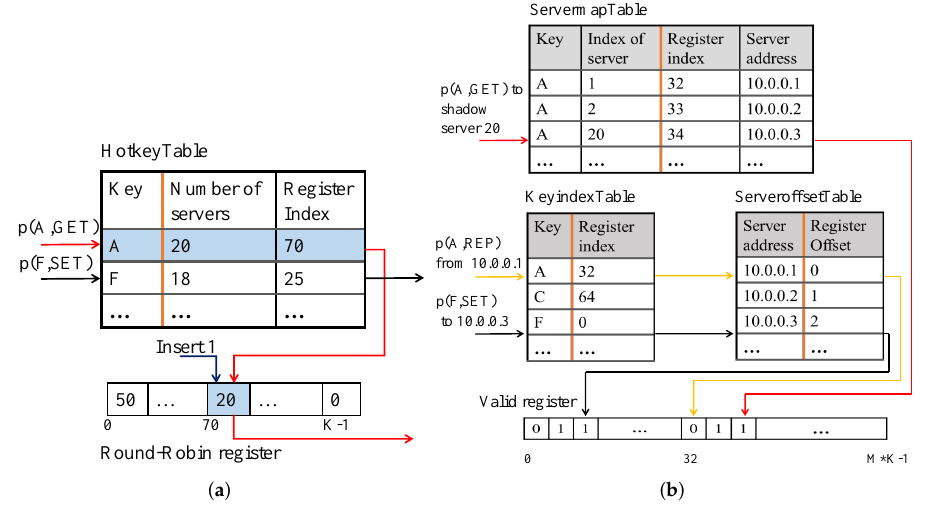
Figure 5. ASIC designs of two important modules. ( a ) Load balance module; ( b ) Consistency